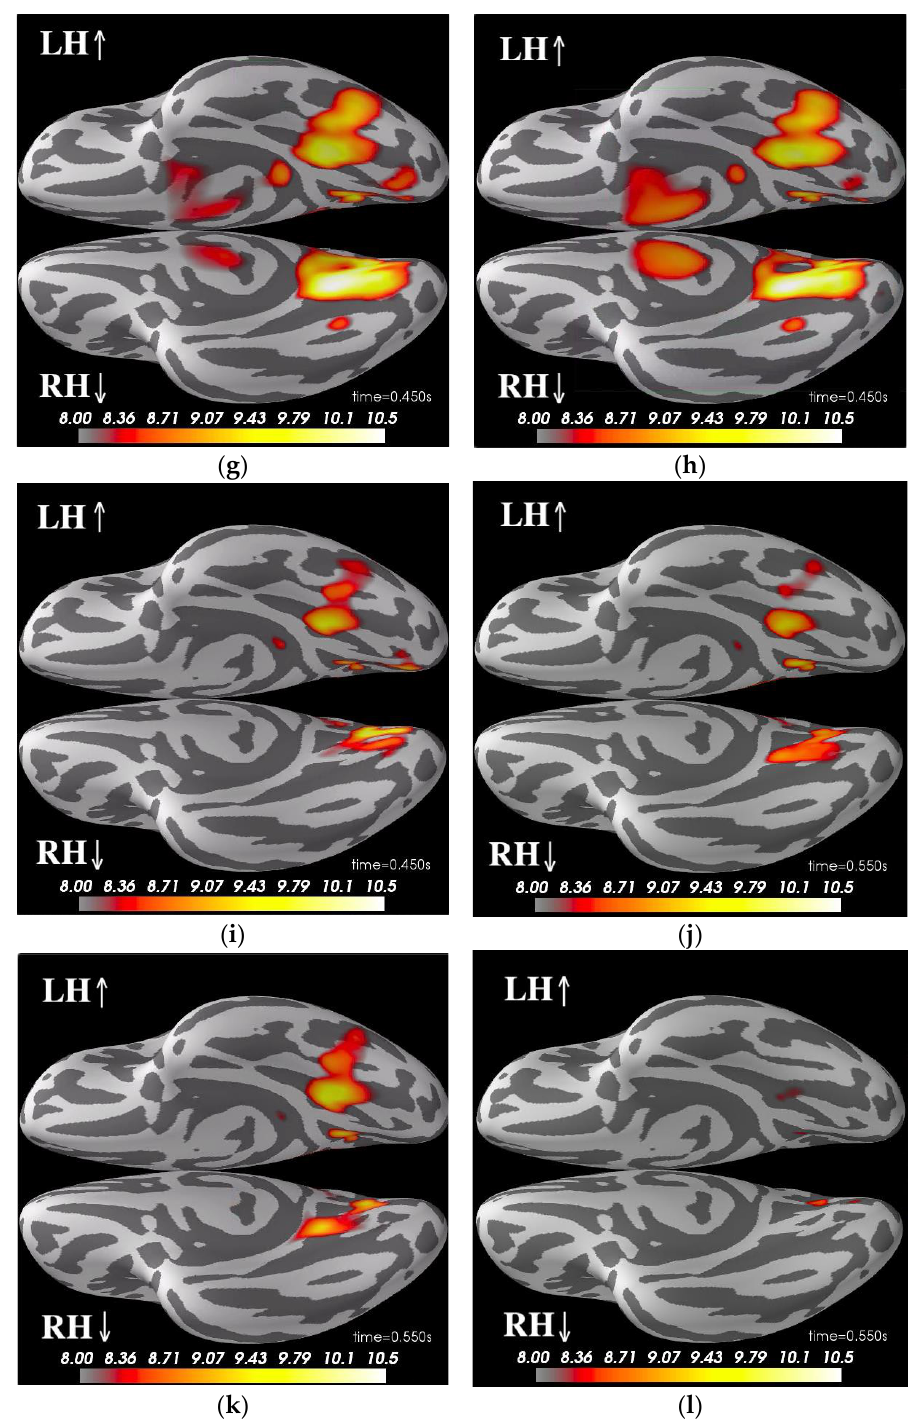
Figure 3. This figure shows dSPM source localization, the significant activities demonstrated here are: ( a ) famous condition IMF4 at 150 ms in left hemisphere (LH); ( b ) famous condition IMF4 at 150 ms in right hemisphere (RH); ( c ) unfamiliar condition IMF4 at 150 ms in LH; ( d ) unfamiliar condition IMF4 at 150 ms in RH; ( e ) scrambled condition IMF4 at 150 ms in LH; ( f ) scrambled condition IMF4 at 150 ms in RH; ( g ) famous condition IMF5 at 450 ms in ventral view; ( h ) unfamiliar condition IMF5 at 450 ms in ventral view; ( i ) scrambled condition IMF5 at 450 ms in ventral view; ( j ) famous condition IMF6 at 550 ms in ventral view; ( k ) unfamiliar condition IMF6 at 550 ms in ventral view; ( l ) scrambled condition IMF6 at 550 ms in ventral